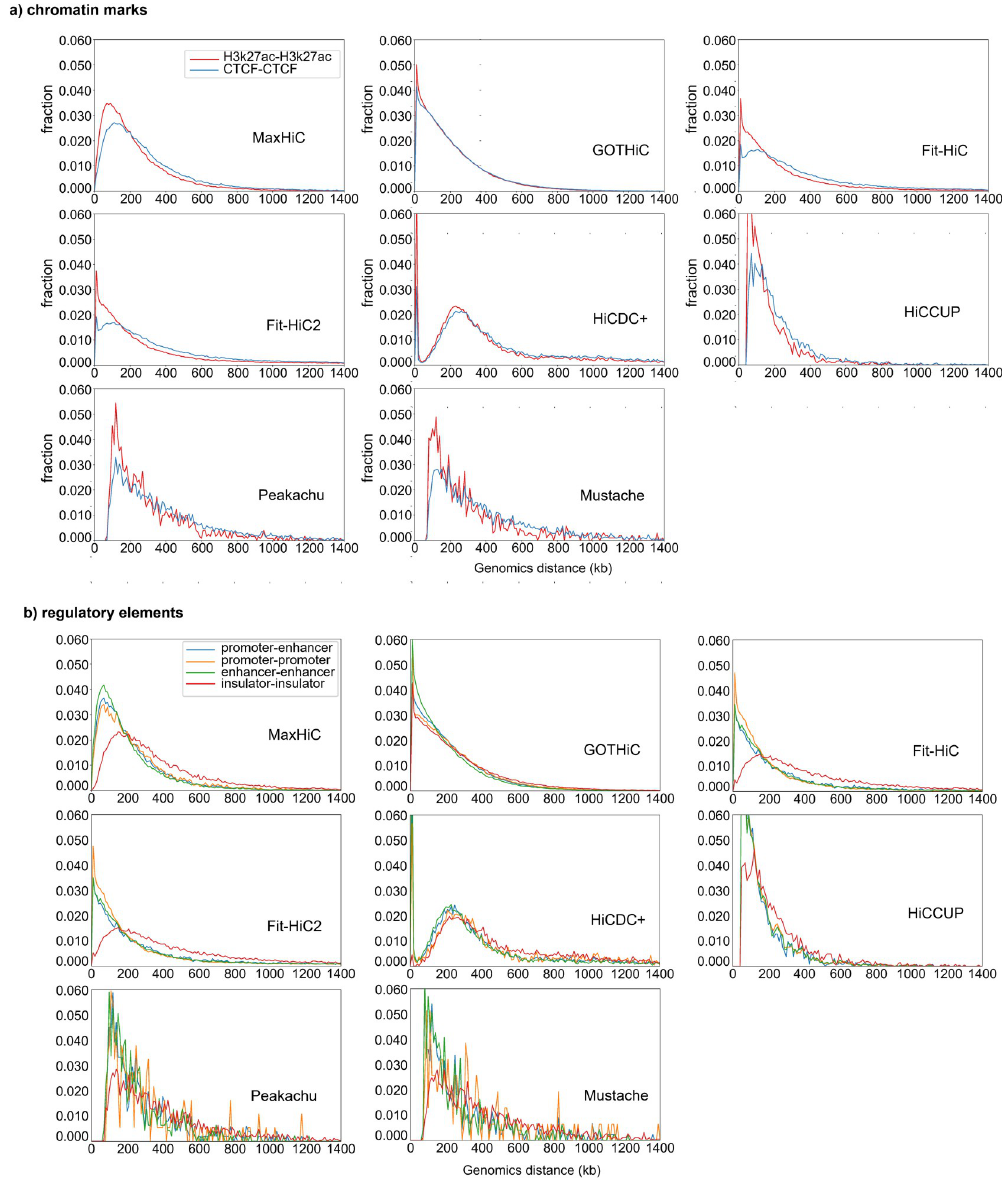
Fig 4. Distance distribution for interactions between different classes of regulatory elements. a) Comparison of spacing observed for H3k27ac-H3k27ac and CTCF-CTCF structural loops in the interactions identified by MaxHiC in the Rao et al . GM12878 dataset. b) Comparison of spacing observed for promoter-promoter, enhancer-promoter, enhancer-enhancer and insulator-insulator pairs in the interactions identified by MaxHiC in the Rao et al . [5] GM12878 dataset. Plots use fragment bin-size 5kb and window size